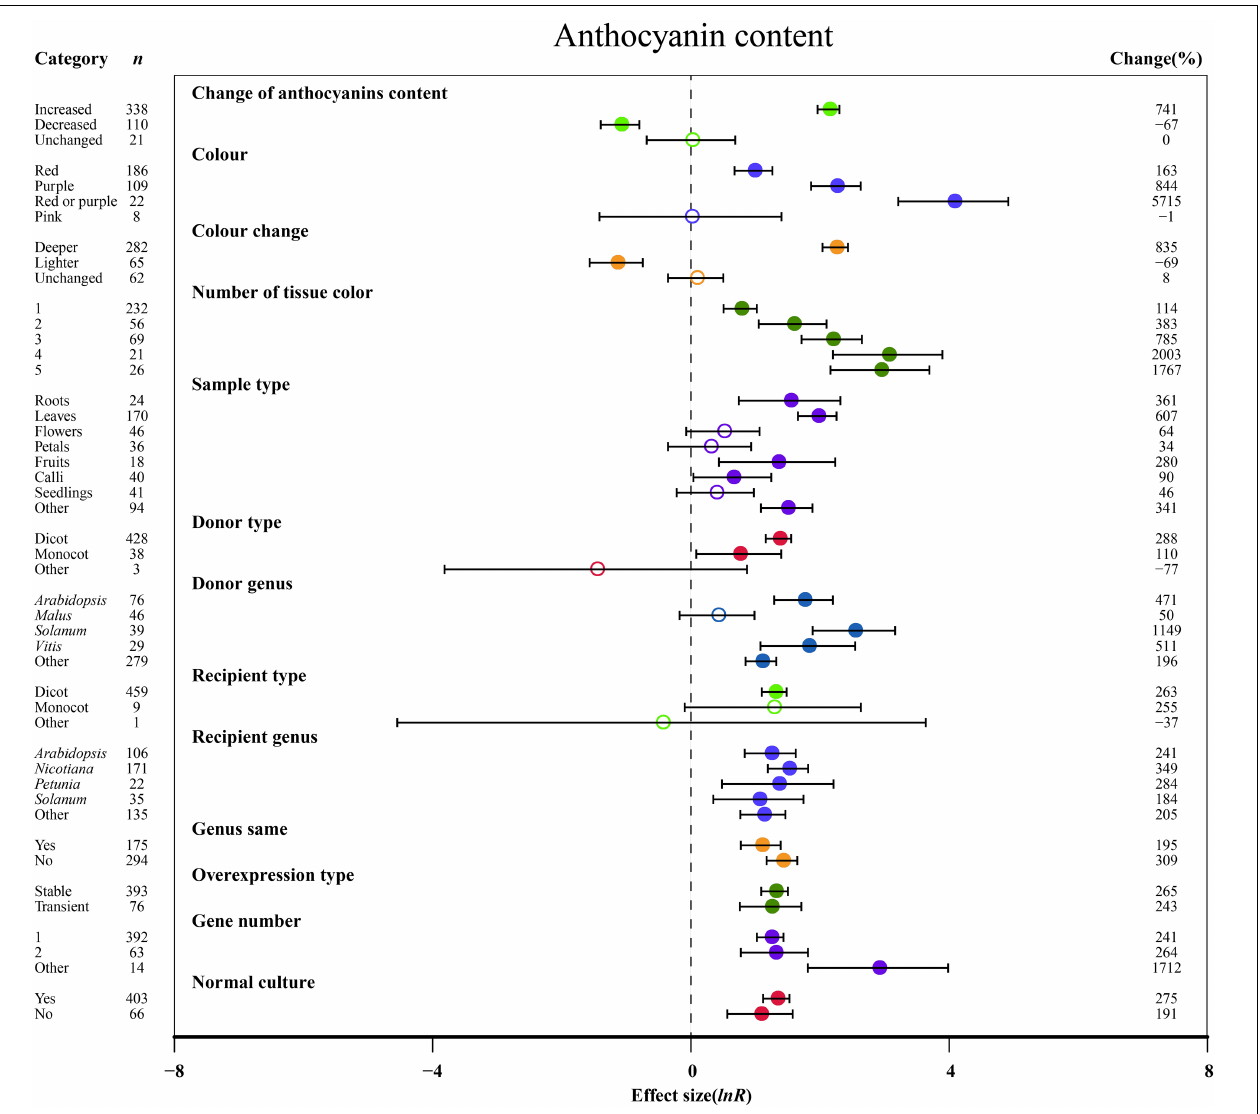
FIGURE 2 | Summary effects (ln R ) of the influence of MYB overexpression on anthocyanin content in plants. Ratios are unit-less. The ratios illustrate the strength of MYB overexpression on the summary effects of anthocyanin content compared with the controls. Circles and horizontal bars indicate the summary effects and the 95% CI of thirteen moderator variables, respectively. n represents the number of studies. Subgroup list levels (subgroups or categories) of each moderator. The percent change (to the right of plots) refers to the raw percentage increase or decrease in anthocyanin content induced by overexpression of MYB . The moderator variables of the examined plants are colored and distinguished by different colors. Closed and open circles indicate the effects of significance and insignificance,